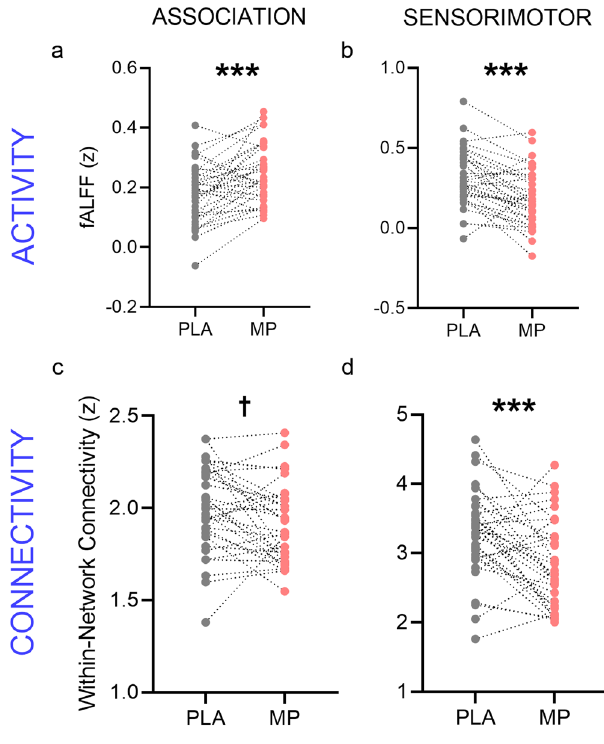
Fig. 3 Methlyphenidate-induced changes in brain activity and connectivity across association and sensorimotor cortices. Methylphenidate (MP)-induced changes in brain activity ( a , b ) and connectivity ( c , d ), relative to placebo (PLA). fALFF fractional amplitude of low-frequency fl uctuations. *** p < 0.001; † p =